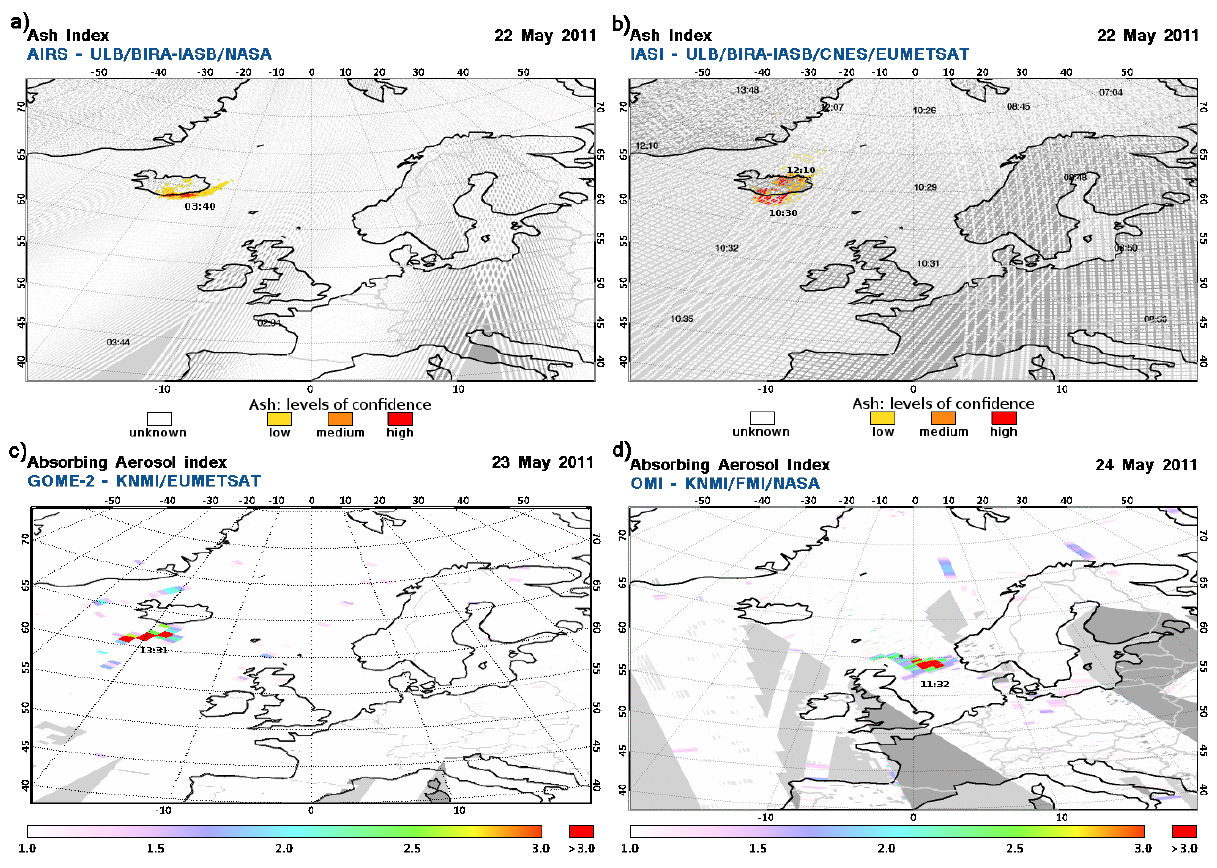
Fig. 4. Ash index from (a) IASI-A and (b) AIRS, and AAI from (c) GOME-2A and (d) OMI during the Grímsvötn eruption on Iceland. Images show the first days of the eruption, which started on the afternoon of 21 May